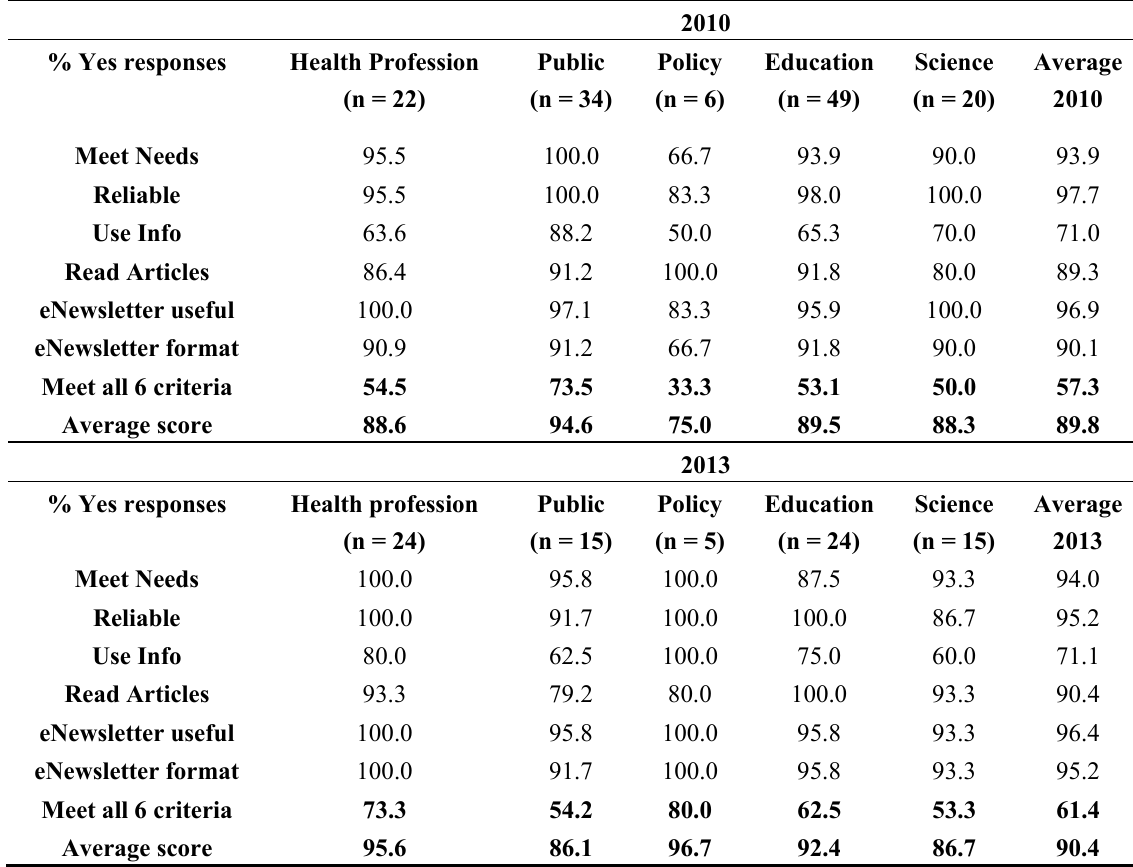
Table 3. 2010 and 2013 by consumer groups and 6 criteria on meeting information needs.